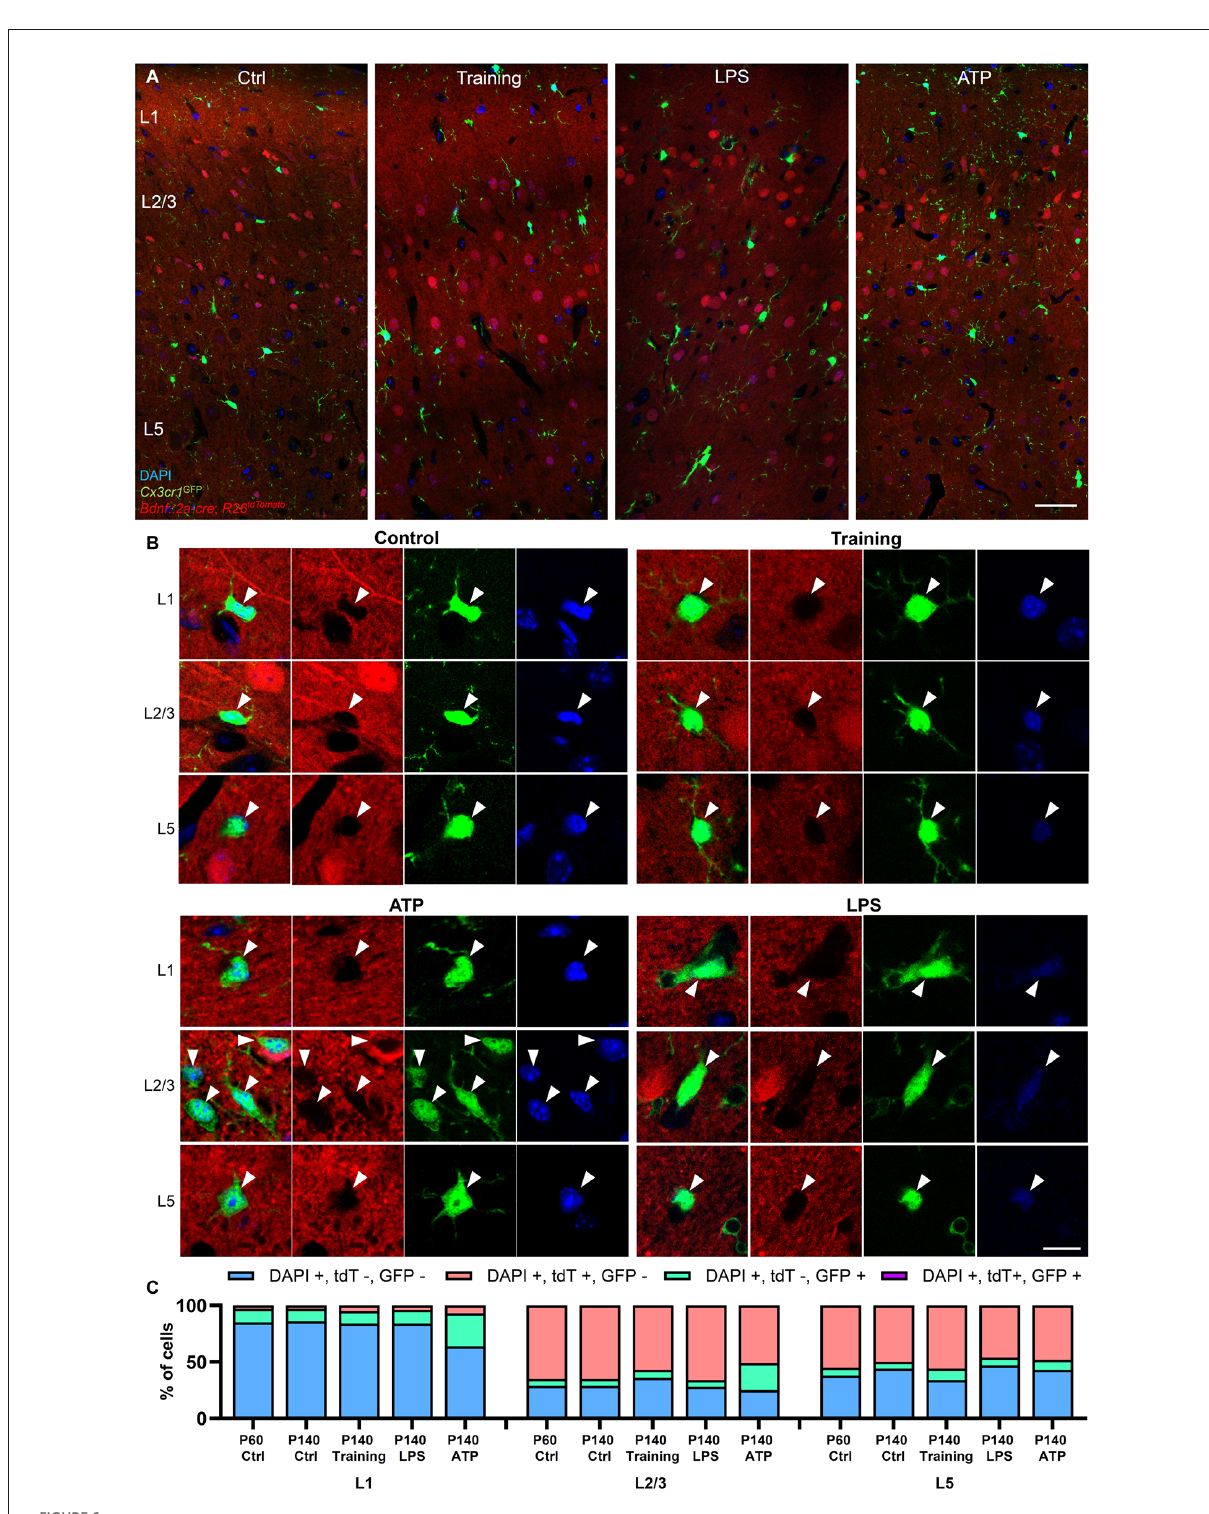
FIGURE6 Training and proinflammatory stimuli do not induce BDNF expression in microglia. (A) Representative images of the motor cortex at P140 in the Bdnf :: 2a-cre ; R26 LSL − tdTomato ; Cx3cr1 GFP reporter system in control conditions, after motor training, 2 days after LPS stimulation, and 7 days after ATP stimulation. (B) Representative high magnification images of GFP-labeled microglia from L1, L2/3, and L5 showing the absence of tdTomato signal after stimulation. (C) Cell quantifications across regions and treatments, showing an increase in GFP-positive microglia after ATP treatment, but no expression of the BDNF reporter in any of the conditions tested. Scale bar: (A) : 50 µ m, (B) : 10 µ